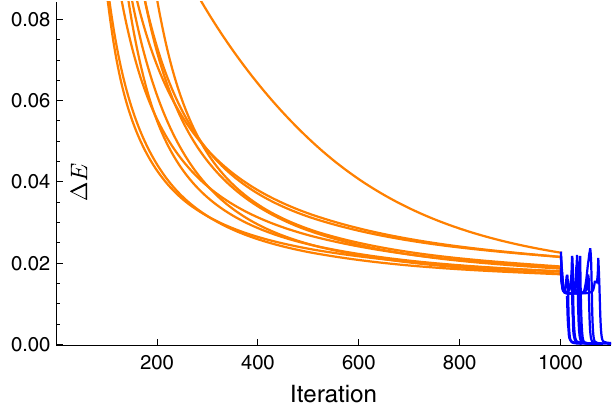
FIG. 13. Ten examples of CoVaR escaping from practical local traps demonstrated on the same ten-qubit spin-chain problem as in Fig. 8. Gradient descent (orange) for 1000 adaptive size steps to reach local minima, followed by 100 iterations of CoVaR (blue). Several steps of CoVaR are sometimes required before finding a set of operators that produce a step that escapes the minimum. Mean energy differences from the ground state are Δ E 0 . 019 and Δ E 1 . 8 × 10 − 4 . The last step of localmin ¼ CoVaR ¼ each run of gradient descent has an energy improvement below 2 × 10 − 5 , indicating being stuck in a local trap. Note that a single iteration of CoVaR does not necessarily decrease the energy, given CoVaR is not an energy minimizer as is demonstrated here but is also visible in Fig. 8. Indeed, escaping from a local trap of the energy surface with CoVaR may result in an intermediate increase of the energy.